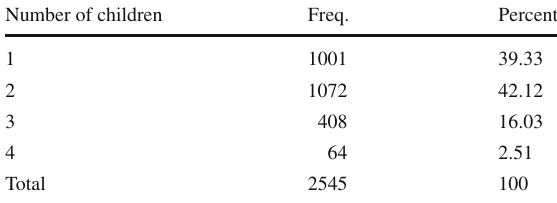
Table 4 Distribution of observations by number of children. Source : SHARE 2004